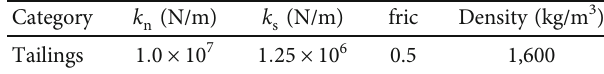
Figure 10: Calibration sequence process of mesoparameters of a linear contact model. Table 4: Values of mesoparameters of tailing